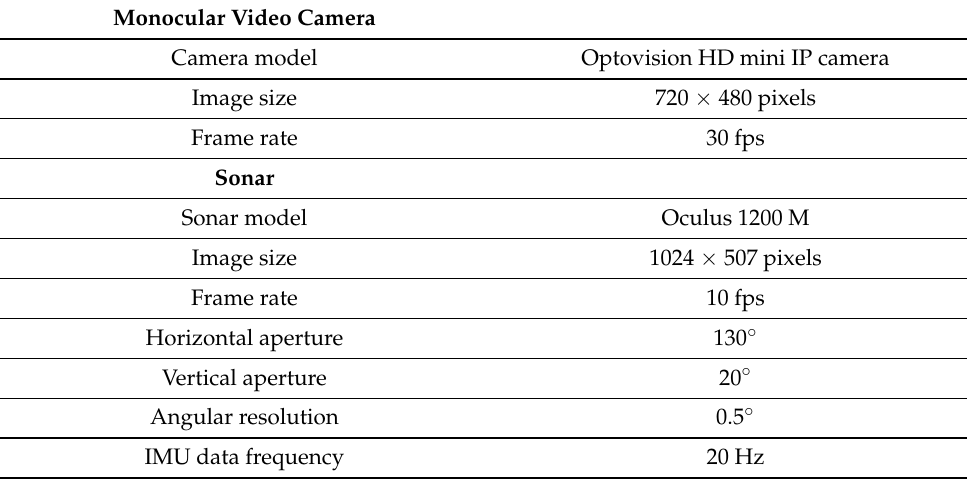
Table 1. Technical data about the sensors of the Basile